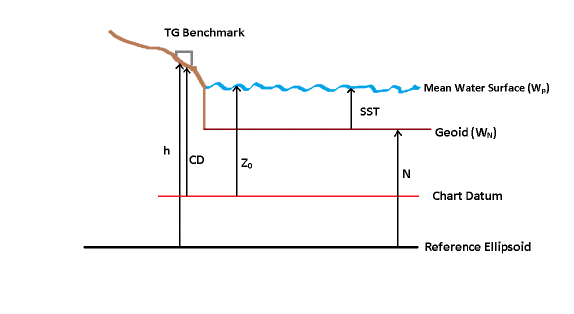
Figure 3. Geometrical evaluation of sea surface topography at tide